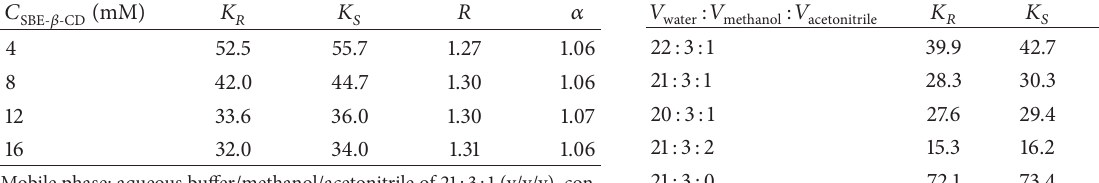
Table 1: Effect of the concentration of SBE- 𝛽 -CD in aqueous phase. 𝐶 SBE - 𝛽 - CD (mM)